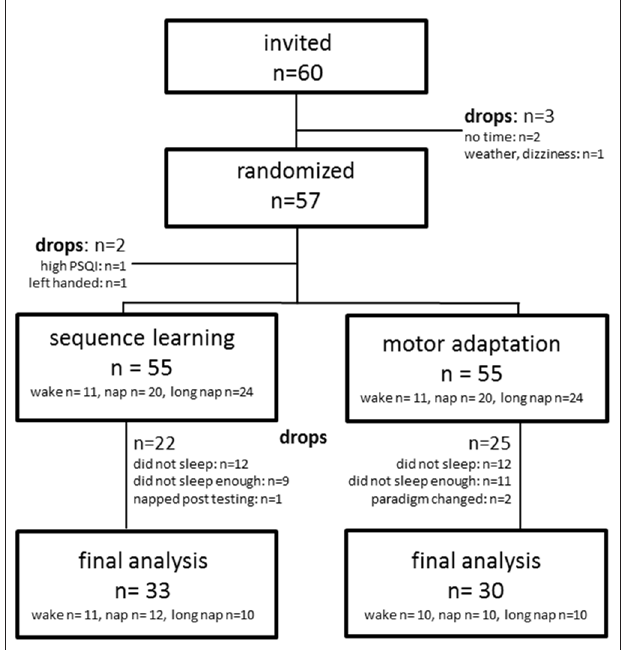
FIGURE 2 | Recruitment algorithm for sequence learning and motor